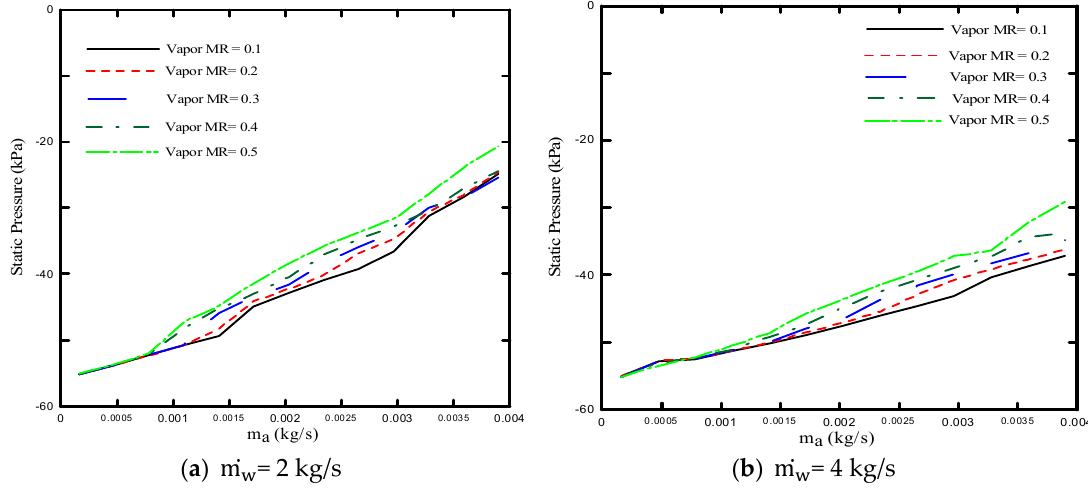
Figure 7. Effect of air and vapor mass flow rates on the static pressure generation in the tube upper region.